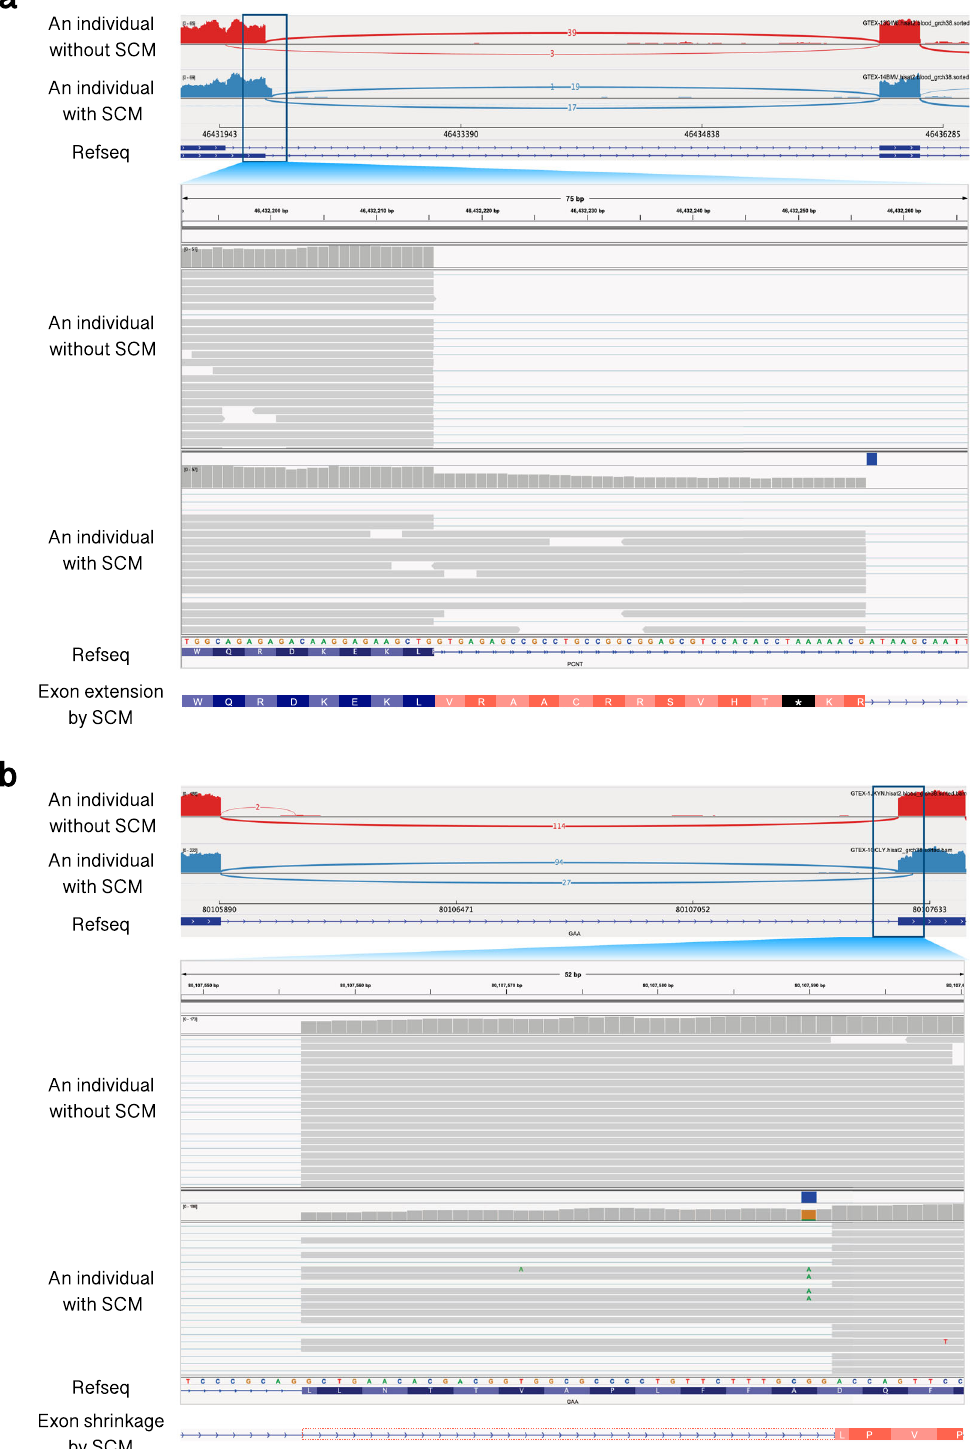
Fig. 2 Examples of novel exons induced by SCMs. a Exon extension by an SCM in intron 38 of pericentrin ( PCNT ). The upper panel illustrates Sashimi plots 56 of the extended exon and the downstream exon. The individuals without and with the SCM are shown in red and blue, respectively. Each number represents the number of the junction reads. The lower part of this panel is a close-up view of the genomic region around the SCM. The SCM is indicated at the top of the individual in a blue rectangle. b Exon shrinkage by an SCM in exon 5 of acid alpha- glucosidase ( GAA ). The upper panel illustrates Sashimi plots 56 of the shrunken exon and the upstream exon. The individuals without and with the SCM are shown in red and blue, respectively. Each number represents the number of junction reads. The lower part of this panel is a close- up view of the genomic region around the SCM. The SCM is indicated at the top of the individual in a blue rectangle and indicated in the sequencing reads as mismatched